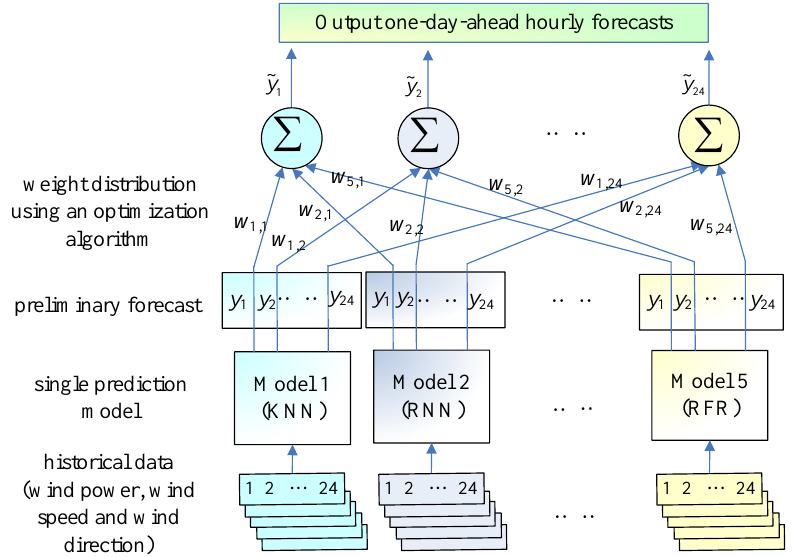
Figure 1. The structure of the proposed